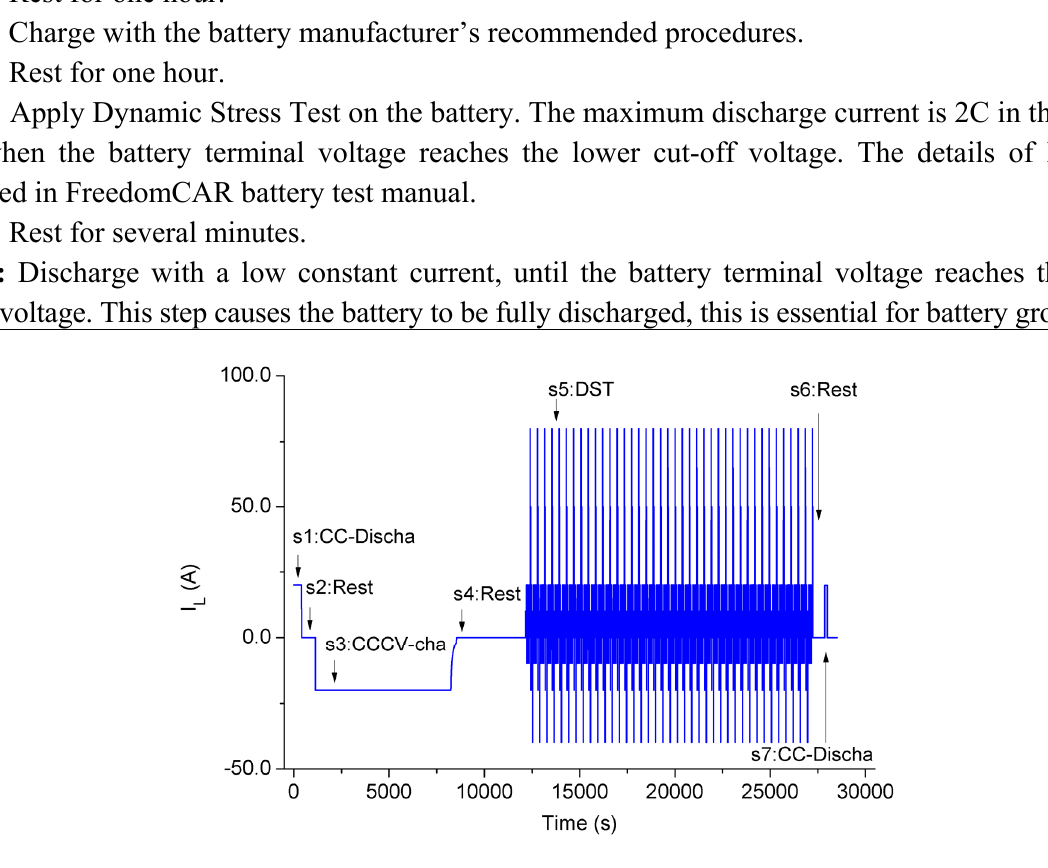
Figure 4. Battery parameter identification experimental